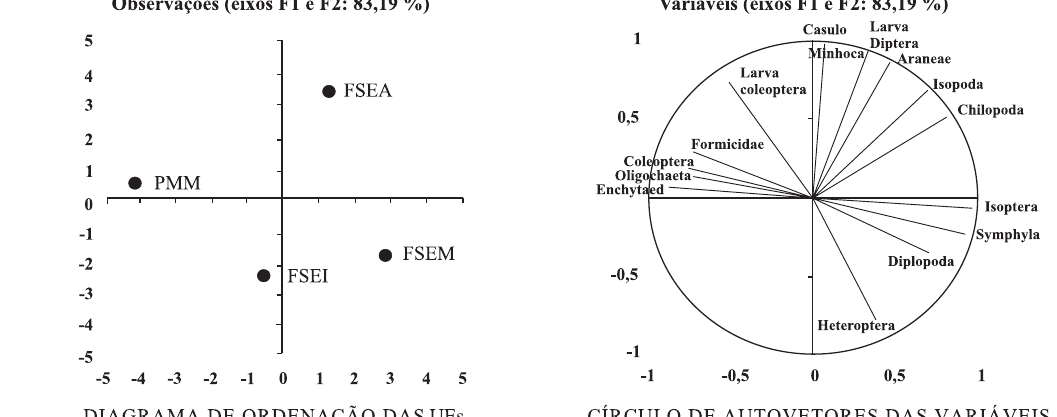
Figura 7. Análise de componentes principais da macrofauna invertebrada do solo sob as diferentes unidades de estudo (UEs) para o período chuvoso. FSEI: floresta secundária estádio inicial; FSEM: floresta secundária estádio médio; FSEA: floresta secundária estádio avançado; PMM: pasto manejado misto.